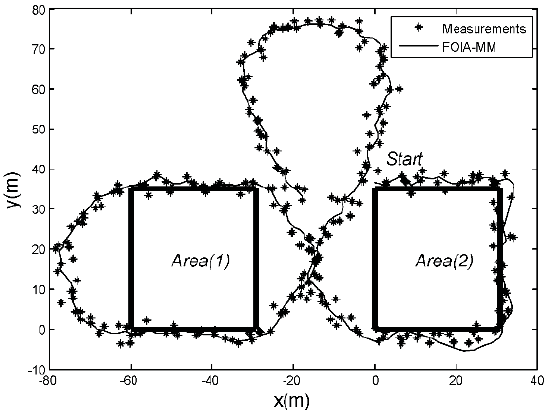
Figure 13. The filtering results of the UAV experiment.